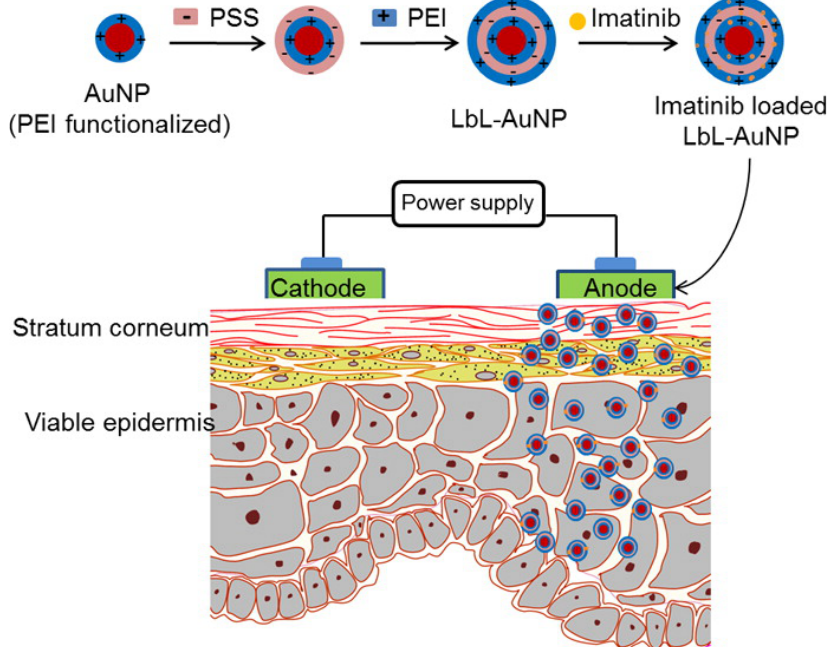
Figure 11. Schematic illustration of imatinib mesylate (IM)-loaded PSS/PEI-AuNPs delivering IM to the layers of skin in melanoma treatment. (Reprinted with permission from [102]. Copyright (2015), American Chemical Society).